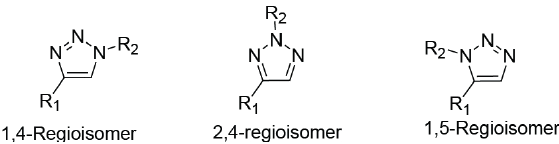
Figure 2 - Different regioisomers of carbon and nitrogen substituted